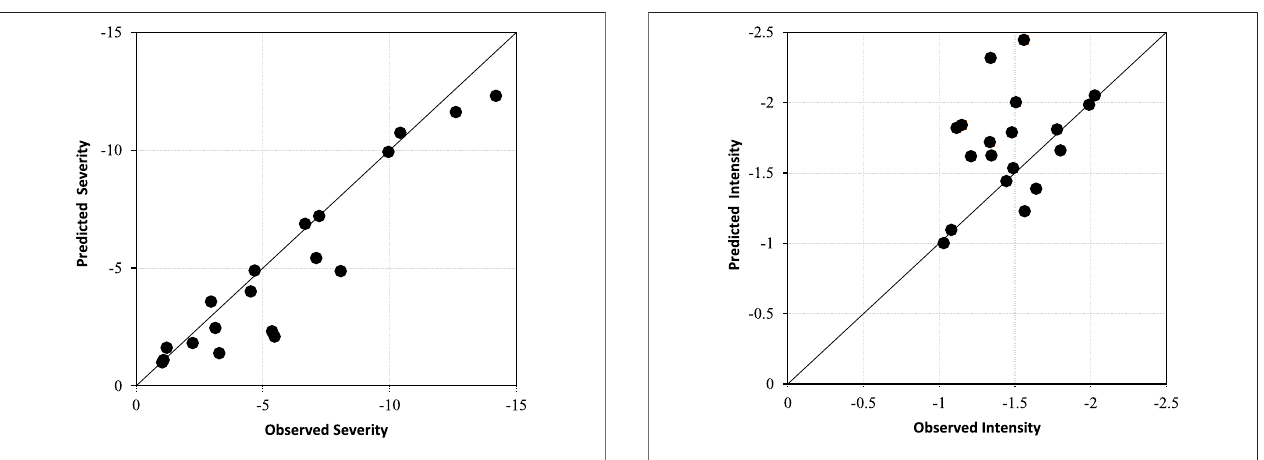
FIGURE 10 | Comparison between observed and predicted drought severity.